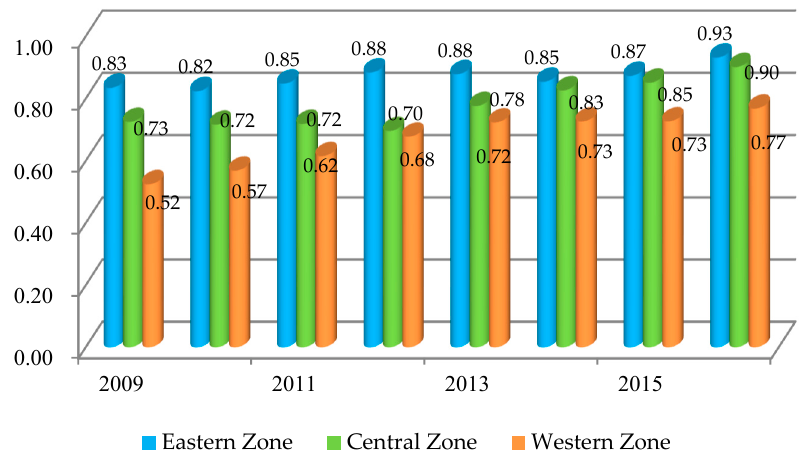
Figure 6. Changes of ITE in the three economic regions during 2009–2016.